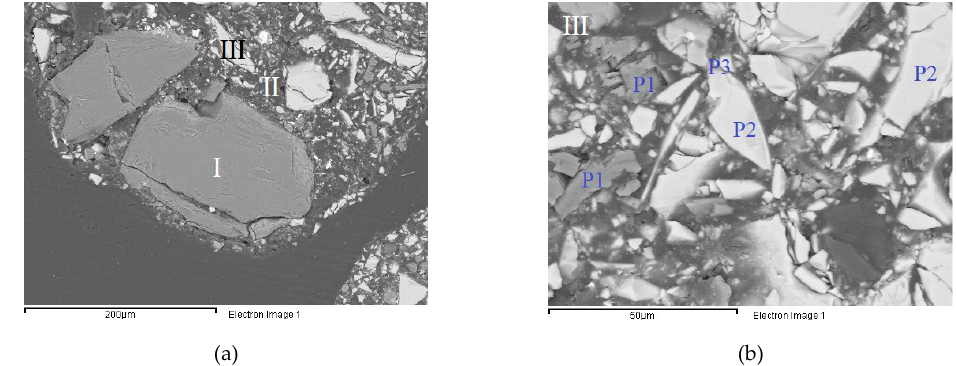
Figure 4. Morphology of original slag: ( a ) full view; ( b ) details of Part III.